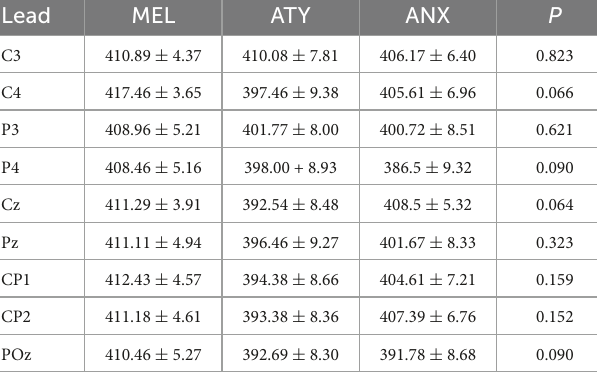
TABLE 5 Comparison of latency of baseline visual P300 task.